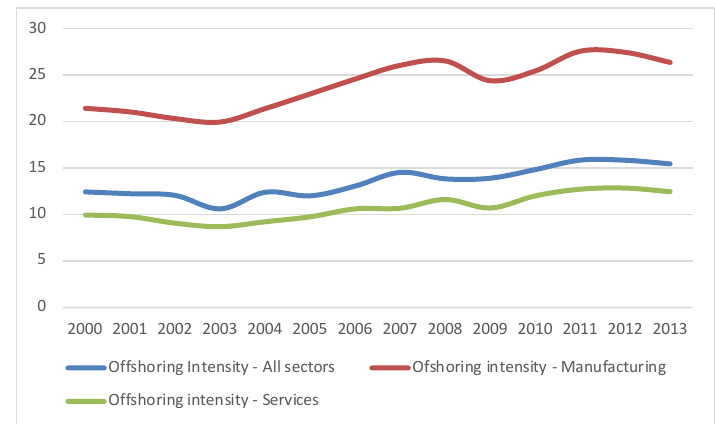
Figure 1. Evolution of offshoring intensity between 2000 and 2013